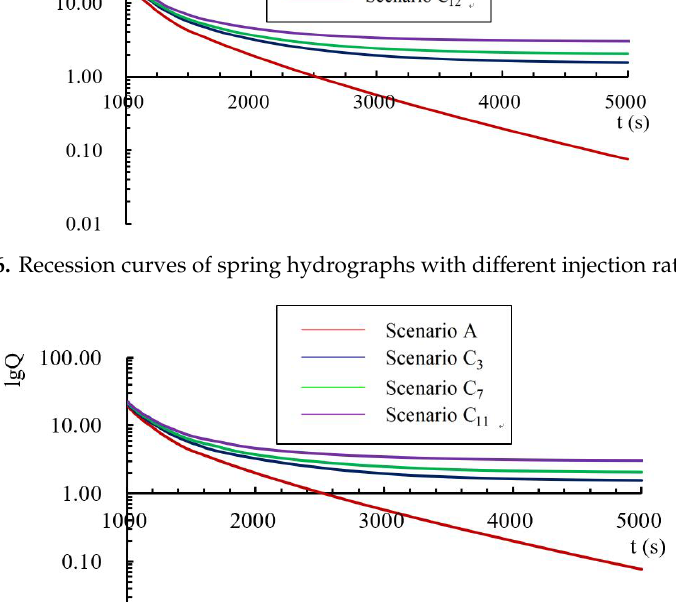
Figure 17. Recession curves of spring hydrographs with different injection rate at W3.